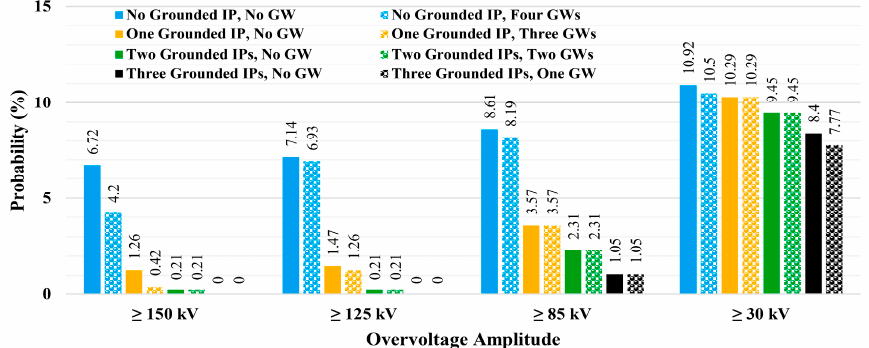
Figure 23. Comparison among the probabilities of transformers experiencing four overvoltage stress levels under different combinations of grounding and guy wire (GW) configurations of intermediate poles (IP); Network with wet creosote-impregnated poles.